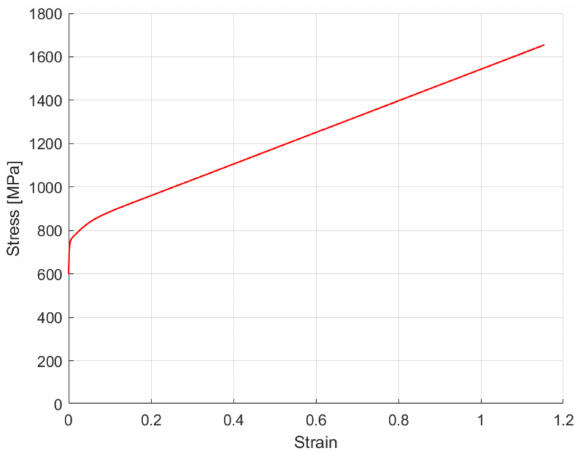
Figure 3. Stress–plastic strain